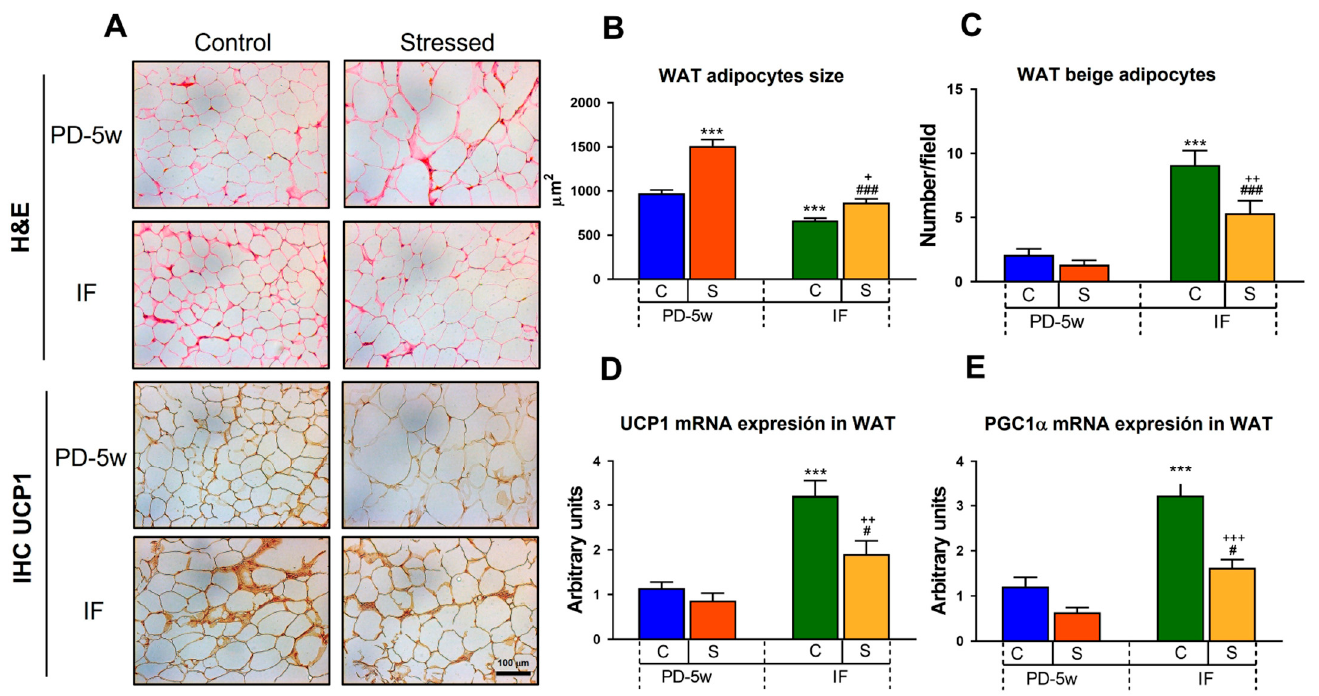
Figure 5. Effect of stress and intermittent fasting on adipose tissue morphology and thermogenesis parameters. ( A ) Representative photomicrographs of hematoxylin and eosin (H&E) and UCP1 immunostaining of mesenteric white adipose tissue (WAT) at 20X magnification of the control or stressed animals fed with a PD and subjected to two feeding schedules: food available all day (with a cumulative intake time of 5 weeks, C-PD-5w, S-PD-5w) or intermittent fasting (C-IF, S-IF) for 3 additional weeks. Scale bar 100 μ m. ( B ) Mesenteric adipocytes’ size. Data are represented as the mean ± SEM of μ m 2 . ( C ) Number of beige adipocytes per field analyzed. Data are represented as the mean ± SEM of the total number of adipocytes/field. ( D ) UCP1 and ( E ) PGC1 α mRNA expression in the WAT. Values are the mean ± SEM of the relative abundance of mRNA levels expressed in arbitrary units. n = 4 rats/group. *** p < 0.001 vs. C-PD-5w; # p < 0.05, ### p < 0.001 vs. S-PD-5w; + p < 0.05, ++ p < 0.01, +++ p < 0.0001 vs.